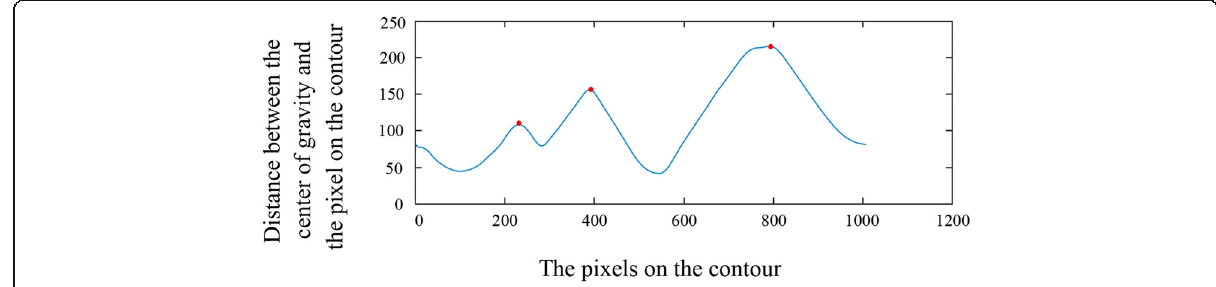
Fig. 10 Curve of the distance value d i d i